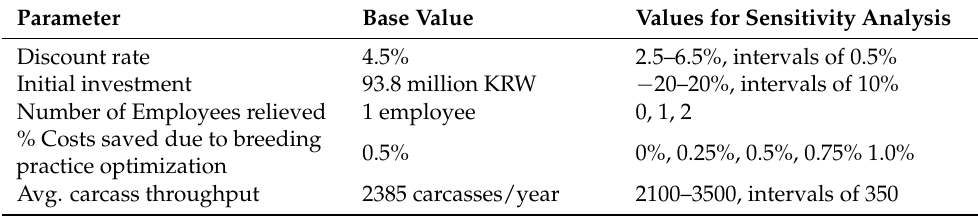
Table 2. Summary of the parameters and respective values considered for sensitivity analysis. Parameter Base Value Values for Sensitivity Analysis Discount